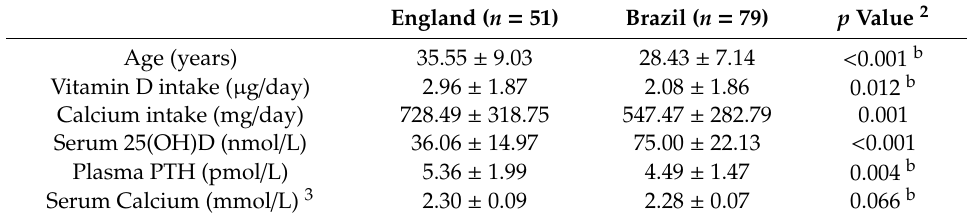
Table 1. Characteristics of adult Brazilian women by country of residence ( n = 135) 1